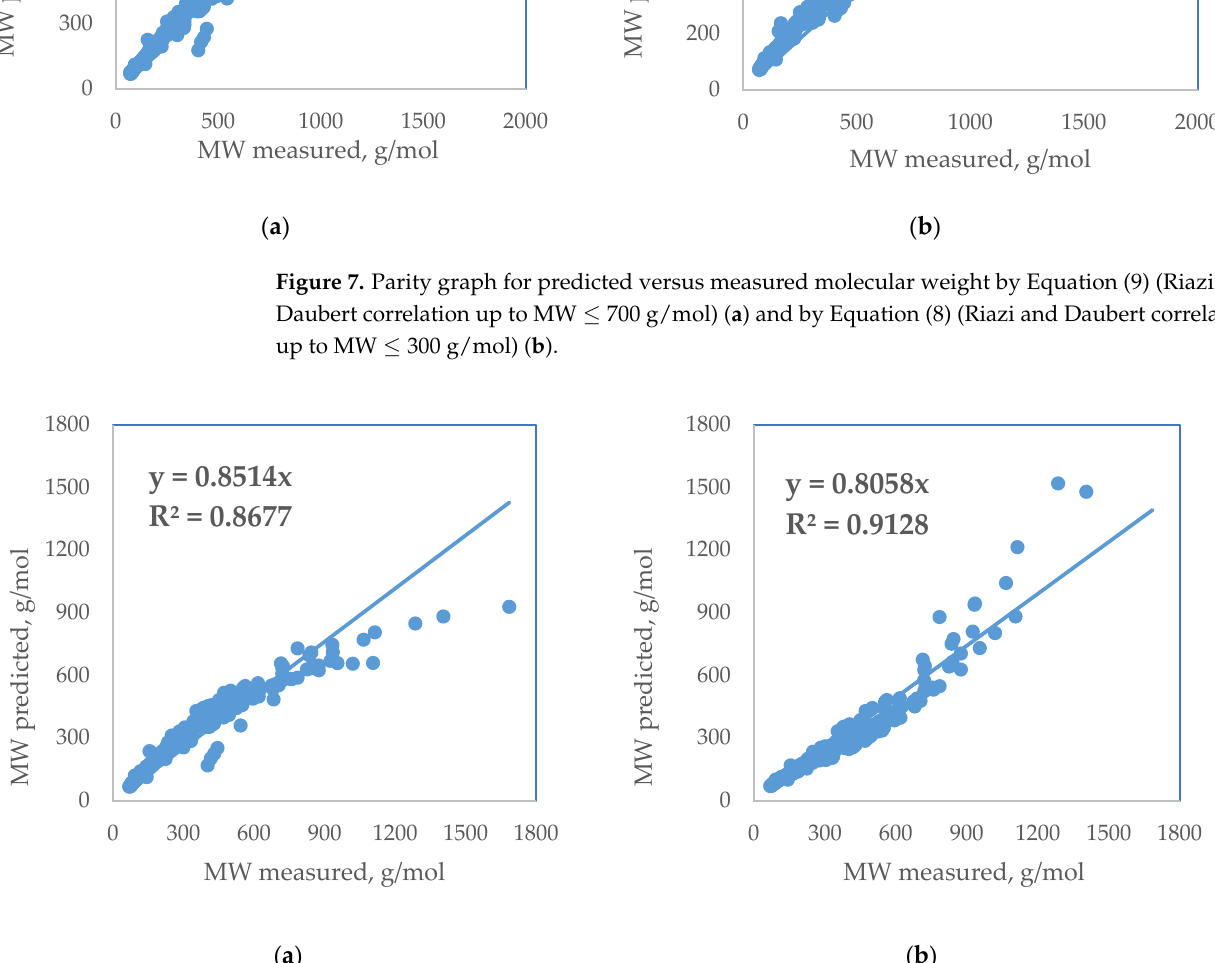
( b ) Figure 9. Parity graph for predicted versus measured molecular weight by Equation (11) (Liñan et al.) ( a ) and by Equation (13) (Hosseinifar, and Shahverdi) ( b ). Table 2 summarizes the statistical analyses for the new empirical correlation, the ANN model, and the ten studied empirical correlations available from the literature. Table 2. Statistical analysis of studied methods to predict petroleum fluid molecular weight for the whole range of studied molecular weights. Standard Error Rel. st. Error